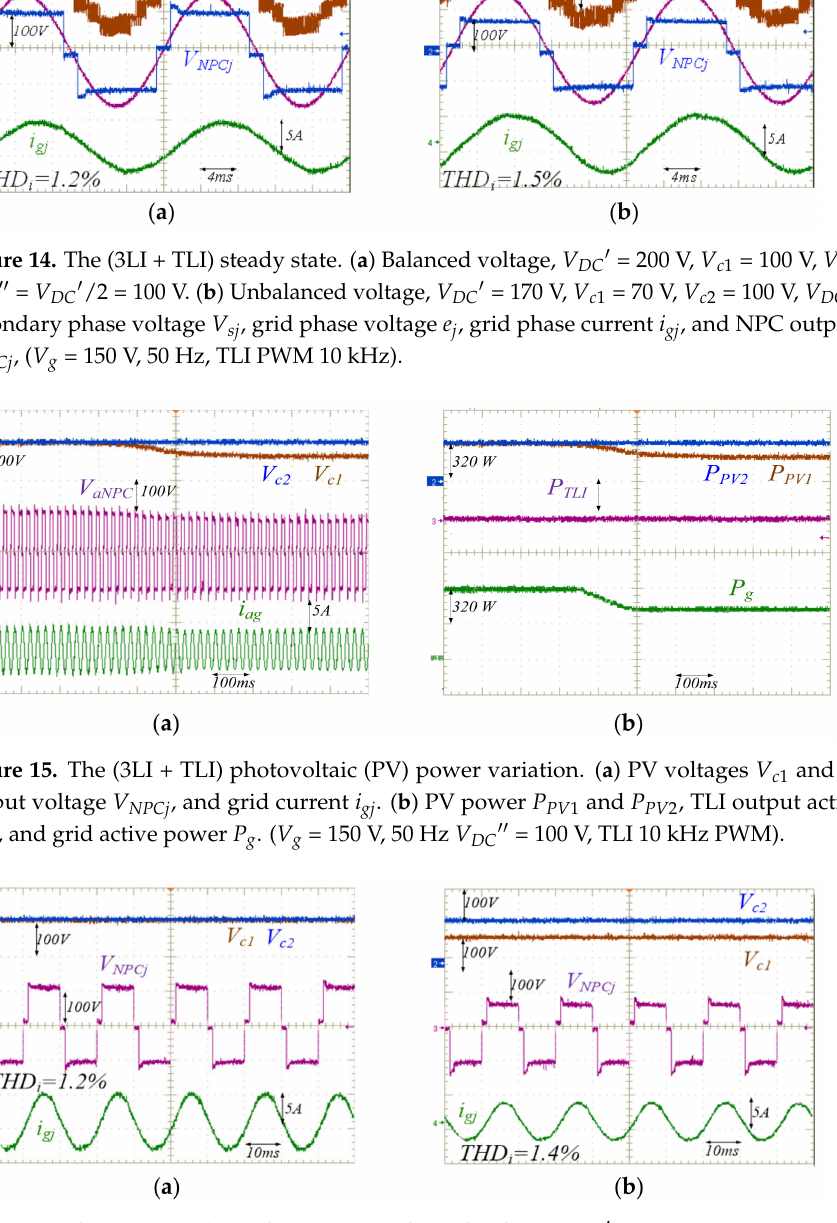
Figure 16. The (3LI + TLI) steady state. ( a ) Balanced voltage, V DC (cid:48) = 200 V, V c 1 = 100 V, V c 2 = 100 V, V DC (cid:48)(cid:48) = V DC (cid:48) /2 = 100 V. ( b ) Unbalanced voltage, V DC (cid:48) = 170 V, V c 1 = 70 V, V c 2 = 100 V, V DC (cid:48)(cid:48) = 100 V. Secondary voltage V sj , grid voltage e j , grid current i gj , and NPC output voltage V NPCj ( V g = 150 V, 50 Hz, TLI 10 kHz